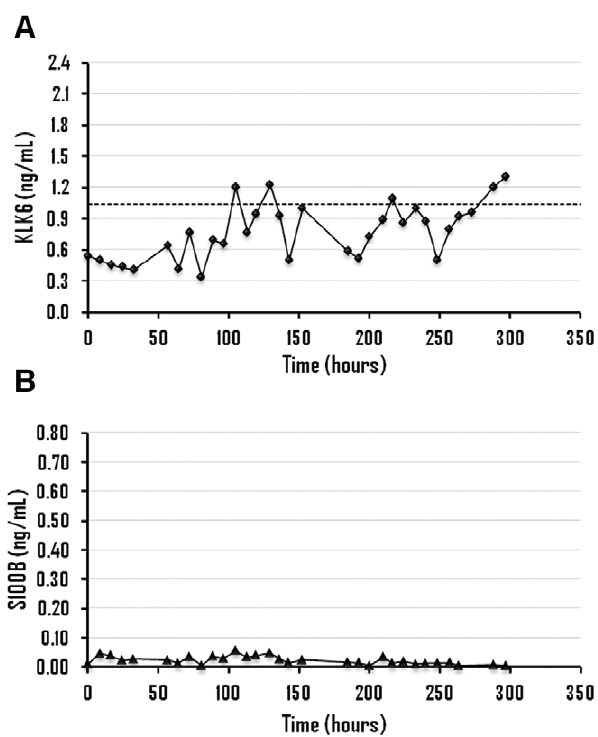
Figure 3. Time evolution of kallikrein 6 (A) and S100B levels (B), in ng/mL, for patient 6.